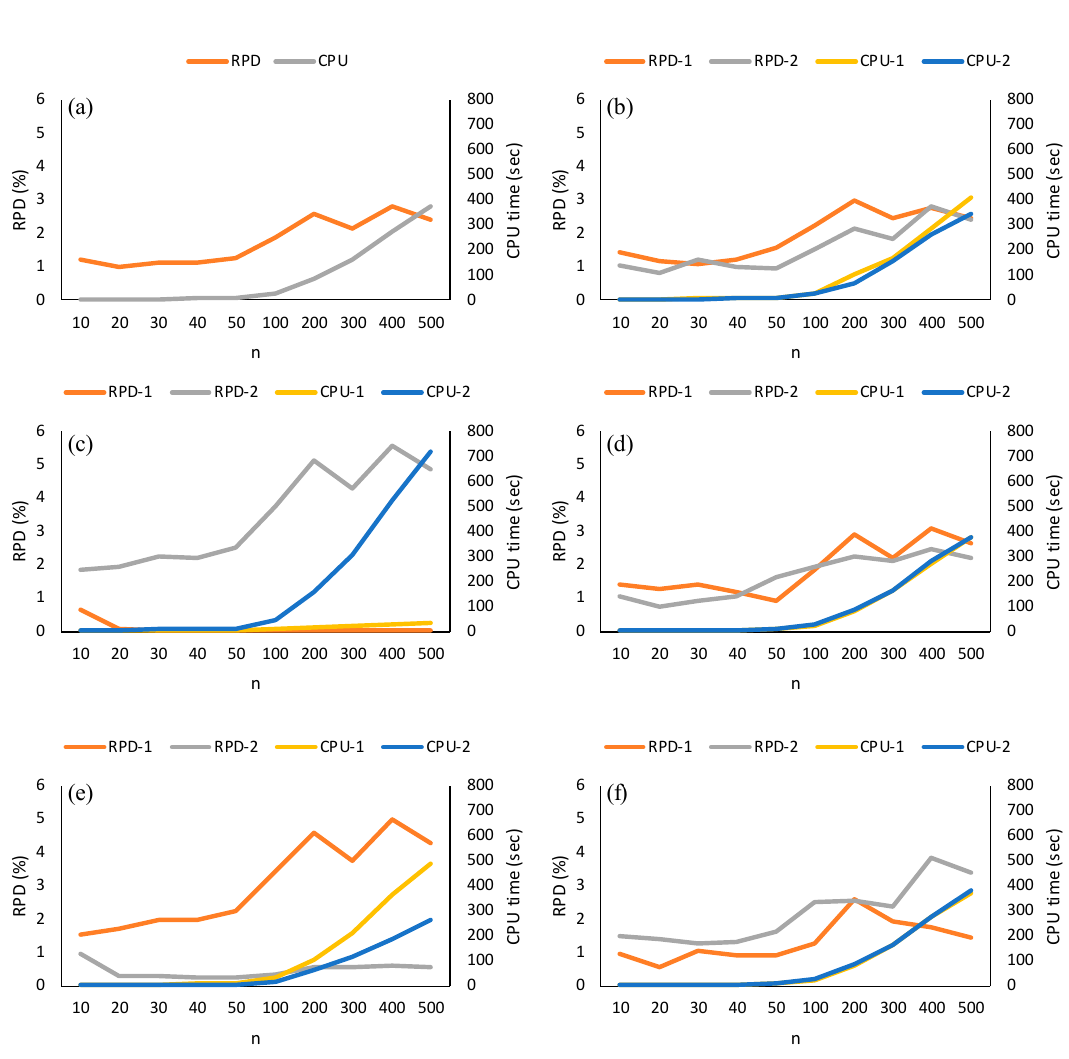
Table 8. Computational results of the RPD.